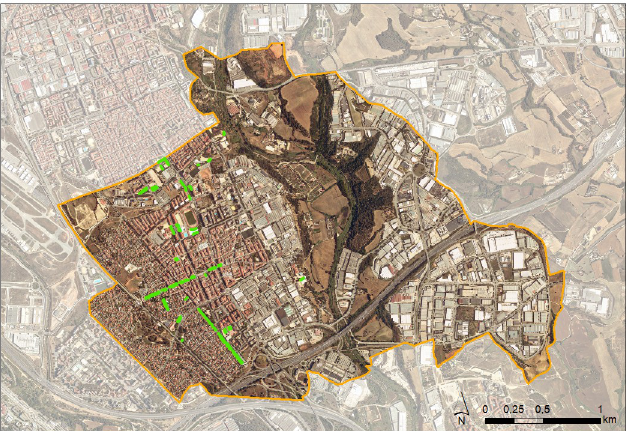
Fig 5. Satellite map of the town of Barber à del Vall è s showing in green the location of its 506 public mulberry trees in 2016. (Map source: Cartographic and Geological Institute of Catalonia, https://www.icgc.cat/, under a CC